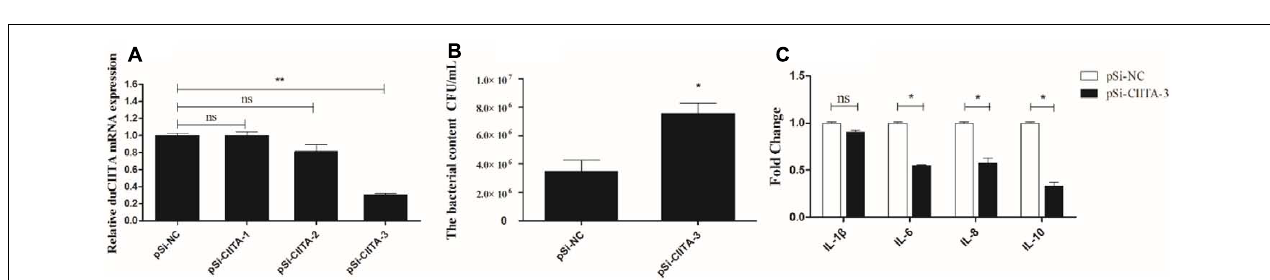
FIGURE 8 | DuCIITA knockdown decreases antibacterial activity and inflammatory cytokine production in DEFs. (A) The DEFs were seeded in 6-well plates and transfected with 1.0 µ g/well of pSi-RNA. After 24 hpt, the cells were collected for duCIITA detection. (B) The DEFs were infected with 1 × 10 6 CFU/mL APEC O1K1 at 24 hpt, the cells were lysed with 10-fold serial dilution and plated onto eosin methylene blue nutrient agar to calculate intracellular bacterial CFU. (C) The DEFs were infected with 1 × 10 6 CFU/mL APEC O1K1 at 24 hpt, then cells were collected for inflammatory cytokine detection. All data were expressed as means ± SD ( n = 3), and Student’s t -test was performed to evaluate the differences. ∗ Significant difference ( P < 0.05); ∗∗ highly significant difference ( P < 0.01).